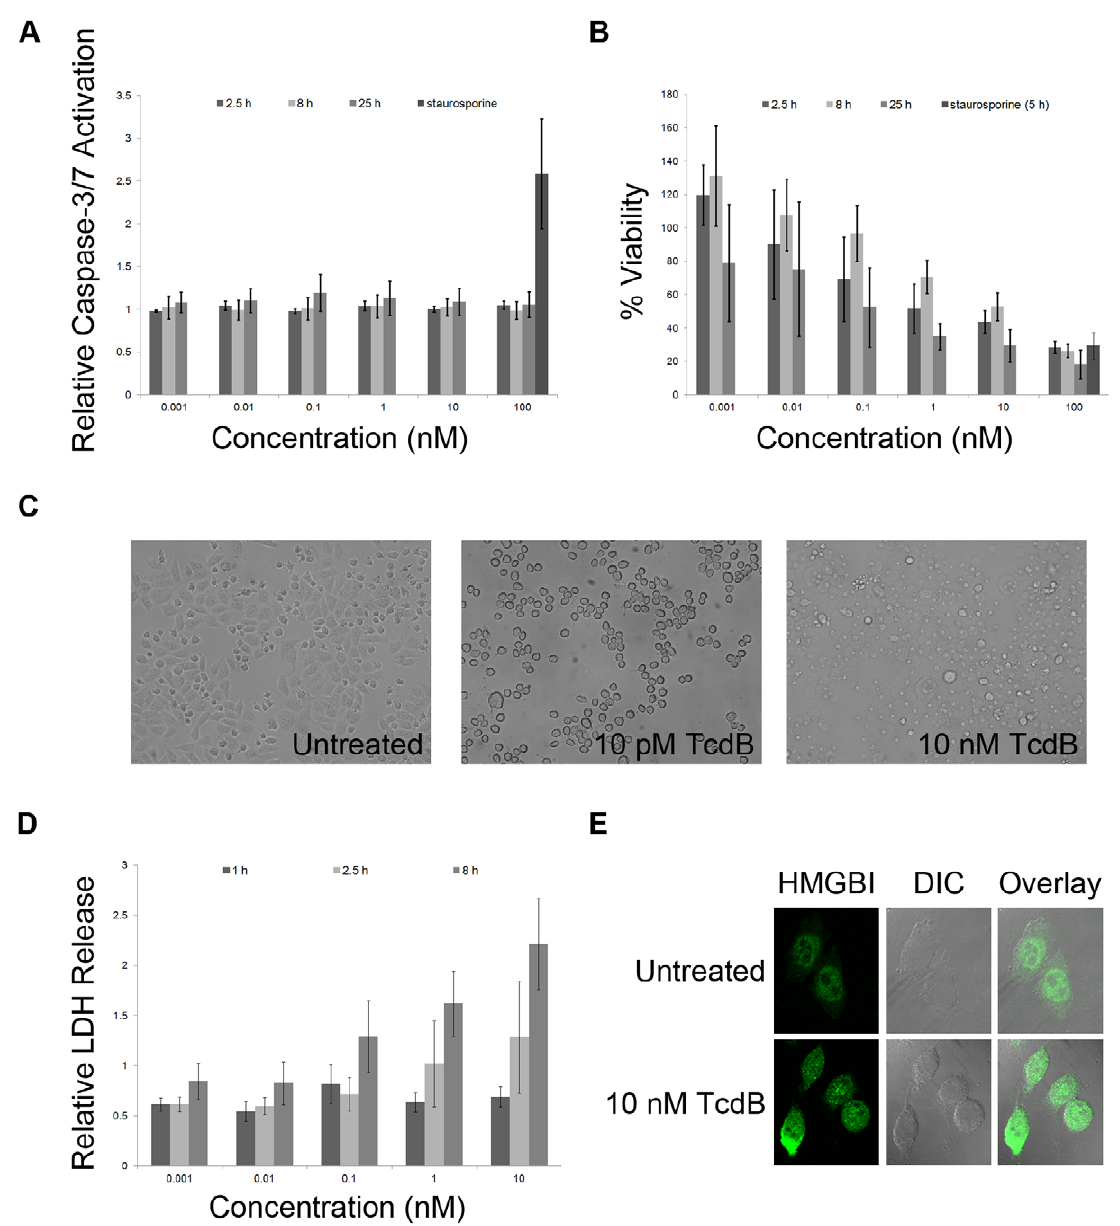
Figure 1. TcdB induces necrosis in epithelial cells. A , TcdB does not induce caspase-3/7 activation in HeLa cells, as detected by a fluorescent indicator, Apo-One. B , TcdB induces rapid death in HeLa cells, as detected by a luminescent indicator, CellTiterGlo. Caspase-3/7 activation and viability values represent the average of three experiments in which each condition was tested in triplicate. The error bars indicate the standard deviation between three experiments. C , HeLa cells were synchronized and incubated with or without TcdB for 2.5 hours at 37 u C. A representative image obtained by light microscopy indicates rounding in cells treated with 10 pM TcdB and a loss of membrane integrity in cells treated with 10 nM TcdB. D , Extracellular LDH was detected in TcdB-treated HeLa cells after 2.5 hours using a luminescence-based indicator, Cytotox-Glo. Increased levels of LDH release were apparent after 8 hours. LDH release values represent the average of three experiments in which three replicates were averaged. Error bars indicate the standard deviation between the values obtained from the three experiments. E , HeLa cells were treated with a buffer control or 10 nM TcdB for 1 h and then fixed with 4% formaldehyde. Cells were stained with an antibody specific for HMGB1 and an Alexa Fluor 488 anti-mouse antibody. The cells were visualized with a LSM510 Confocal microscope. The representative images show that HMGBI is released from the nucleus of HeLa cells when treated with 10 nM TcdB and remains nuclear in the untreated cells. doi:10.1371/journal.ppat.1003072.g001 (Figure 2A). TcdB autoprocessing can be induced with the stained SDS PAGE (Figure 2A) and densitometry (Figure 2B). addition of 1 uM InsP6, and the amount of processing increases TcdB D587N and TcdB L543A had residual cleavage activity, but as the concentration of InsP6 increases. At all concentrations of were significantly cleavage-impaired. Cleavage of D587N was not InsP6, TcdB C698S, TcdB C698A, and TcdB H653A were induced until 100 uM InsP6 was added, and the amount of completely inactive in autoprocessing, as detected by Coomassie- processed toxin was reduced.